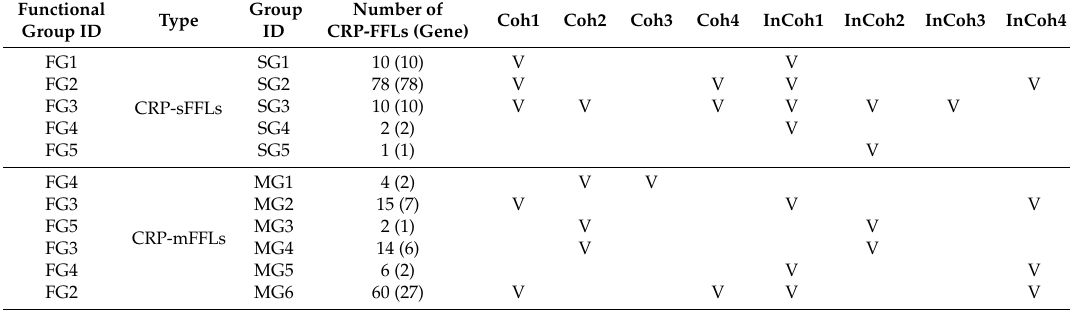
Table 3. Detailed information on CRP-sFFLs and CRP-mFFLs. CRP-sFFLs and CRP-mFFLs are respectively composed of five and six groups involved in various types of FFLs (checked types). Five functional groups are listed using a functional group identifier. Each group is listed according to the expression pattern. The symbol V indicates that the type of FFL configuration contained in the Functional